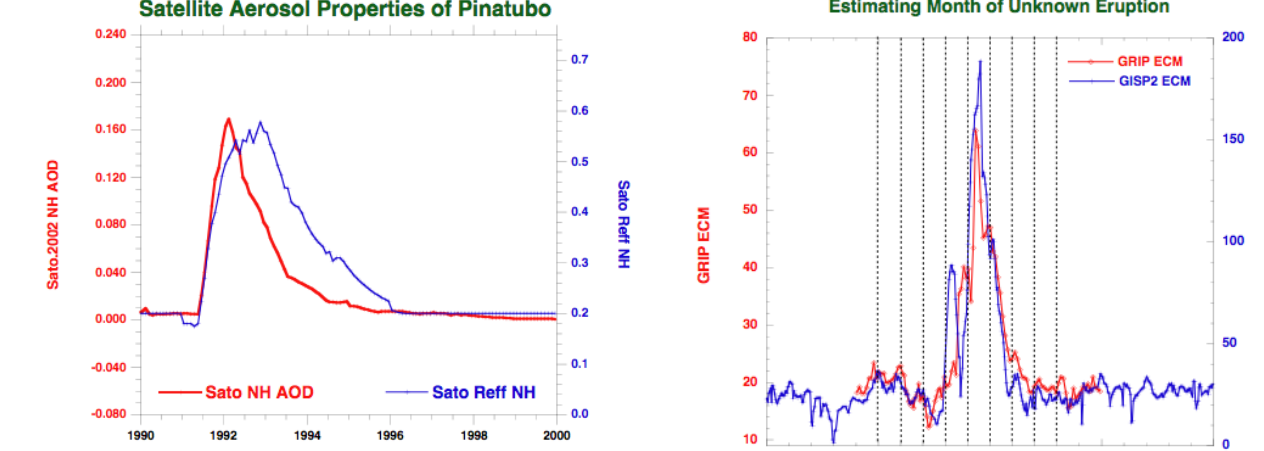
Figure 7. Comparison of bimonthly-scale ECM profiles of GISP2 and GRIP at the time of the “1258” eruption, with small peaks (vertical dashed lines) indicating winter peak of snow accumulation. ECM data for GISP2 from Taylor et al. (1997, ftp: // ftp.ncdc.noaa.gov / pub / data / paleo / icecore / greenland / summit / gisp2 / ecm / ); GRIP data after Clausen et al. (1997). ECM data in µ Eqkg − 1